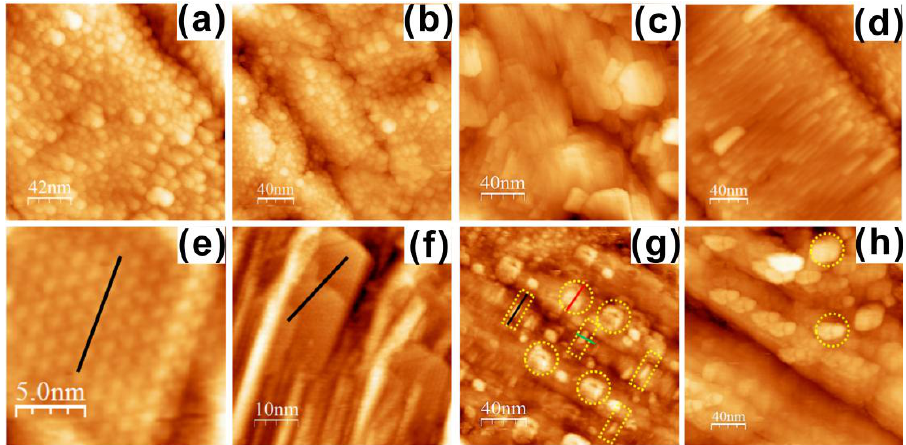
Figure 11. ( a , b ) STM image of the aged surface from the as-grown single crystal; ( c , d ) Magnified view at various positions from the pristine crystal; ( e , f ) Ordered structures having well-aligned stacked planes from the pristine perovskite crystal surface; ( g , h ) STM images showing the hydrate formation after overnight exposure to ambient air with ring-like protrusions (marked by circles) and the disordered 1D chain (marked by rectangles), indicating molecular water incorporation in the pristine surface. Scanning parameters: V b = 2.5 V and It = 0.7 nA. The figure was taken from Reference [65] with permission.